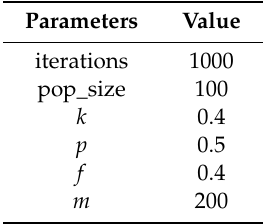
Table 1. Experimental parameters.